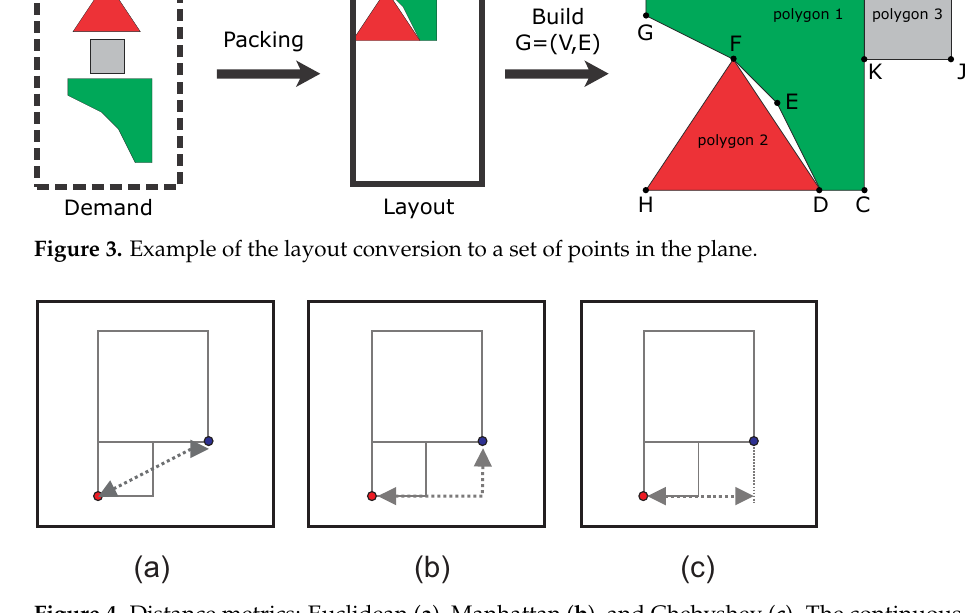
Figure 4. Distance metrics: Euclidean ( a ), Manhattan ( b ), and Chebyshev ( c ). The continuous lines represents the layout, and the points in red and blue represent the two points considered in our example of the three distances used. The dashed lines represent the value of the distance between these two points. The Euclidean distance is the usual shortest line that connect both points; the Manhattan distance is the horizontal euclidean distance plus the vertical Euclidean distance between them; and, finally, the Chebyshev distance is the maximum value between horizontal and vertical Euclidean distances.